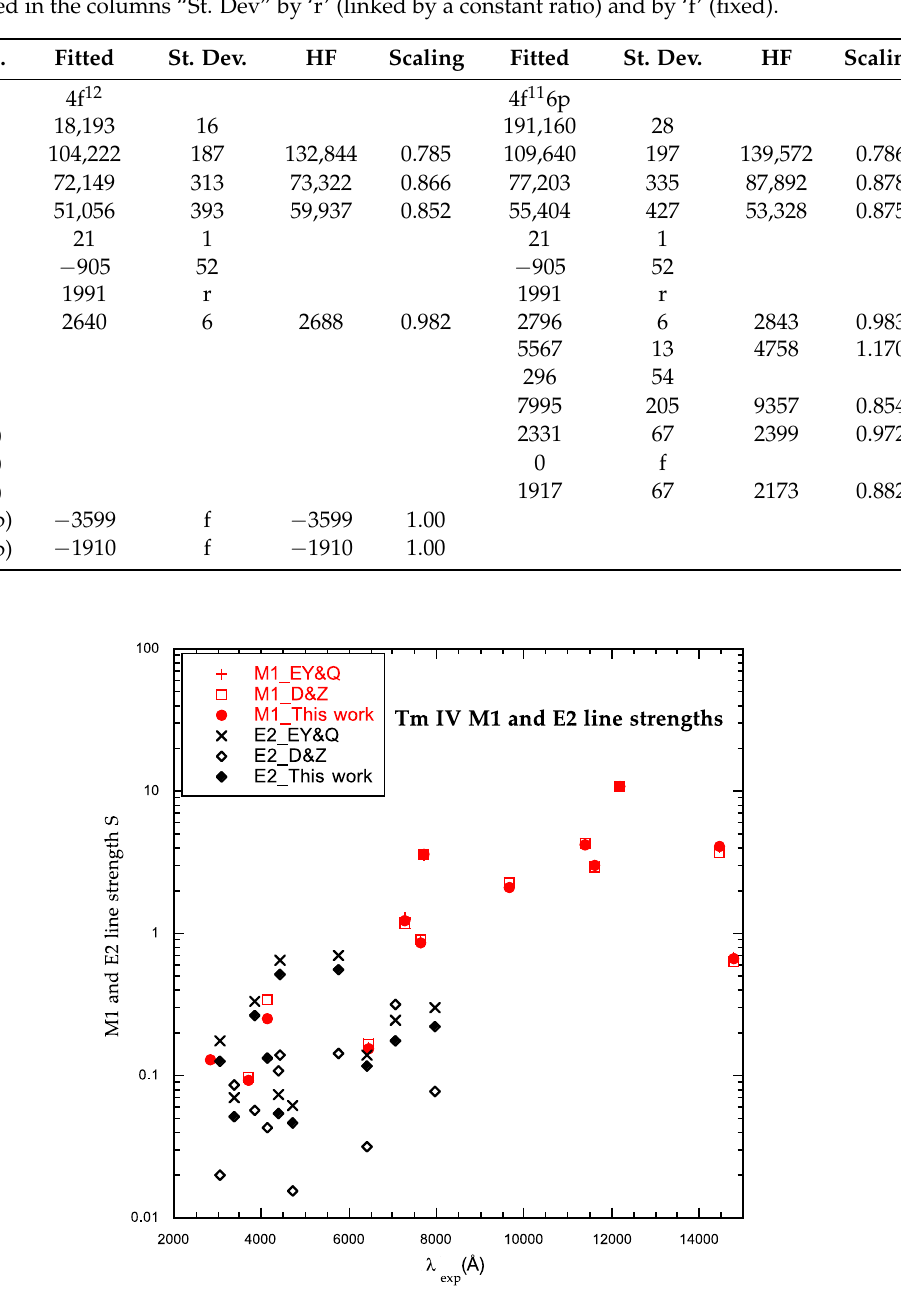
Figure 1. Magnetic dipole (M1) and electric quadrupole (E2) line strengths in Tm IV for lines between 2000 and 15,000 Å.